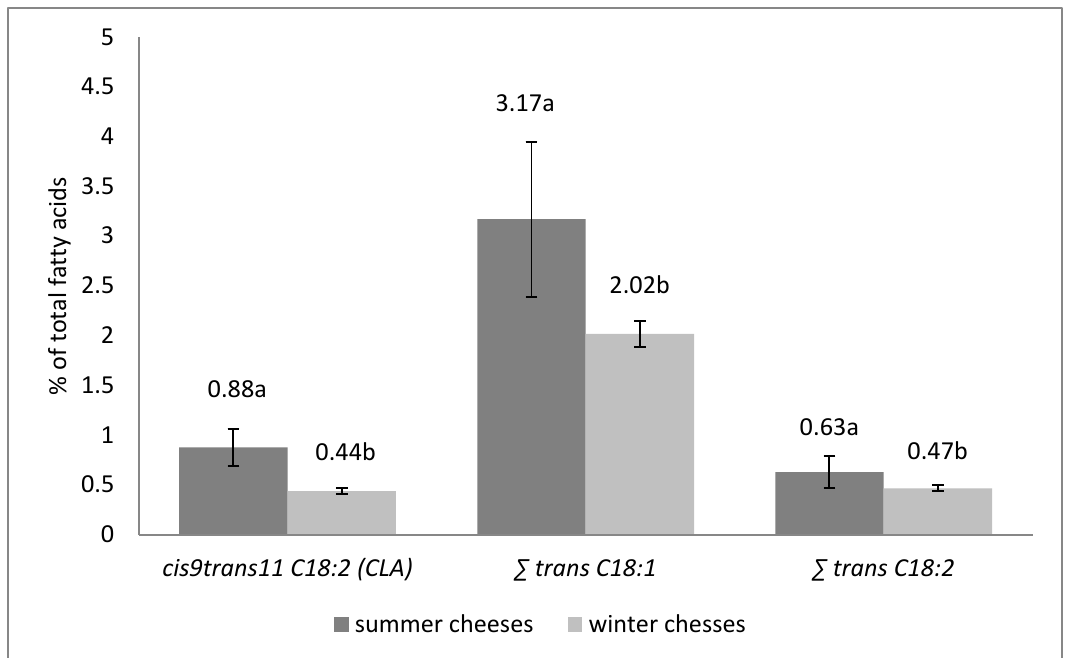
Figure 2. The content of cis 9 trans 11 C18:2 (CLA) and total C18:1 and C18:2 trans isomers (% of total fatty acids) in summer and winter cheeses made from cow’s milk. ∑ trans C18:1—sum of trans isomers of C18:1, ∑ sum of trans C18:2 without c 9 t 11 C18:2, a,b—statistically significant differences ( p < 0.05).